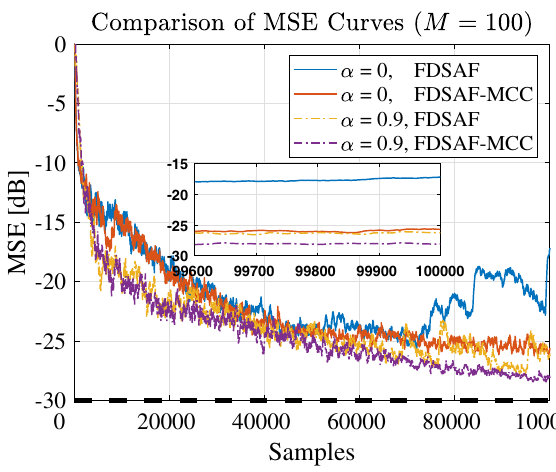
Figure 10. Experiment 3: MSE curves of FDSAF-MCC and FDSAF under impulsive noise with different a